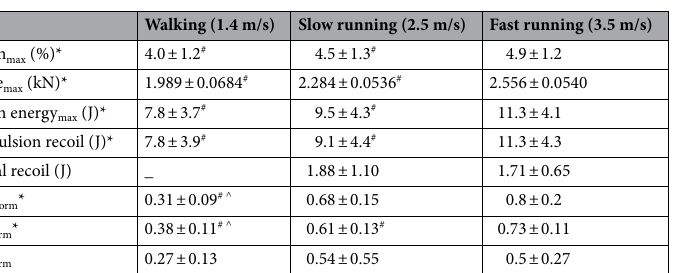
Table 3. Peak values of strain, force and strain energy of the Achilles tendon (AT) as well as maximum normalized EMG activities of the gastrocnemius medialis (GM norm ), soleus (Sol norm ), and tibialis anterior (TA norm ) during walking and running. Furthermore, elastic strain energy recoil during the propulsion phase and at the initial part of the stance phase is presented (average value ± standard deviation). *Statistically significant gait effect (p < 0.05). # Statistically significant differences (post hoc analysis) to fast running (p < 0.05). ^ Statistically significant differences (post hoc analysis) to slow running (p <